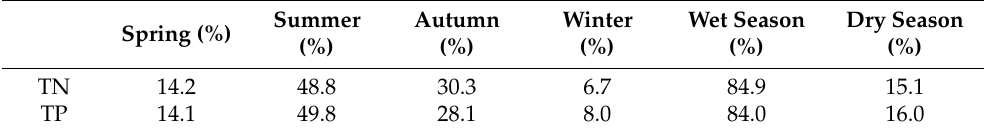
Table 3. The proportions (percentage) of external loading in different seasons as a fraction of the